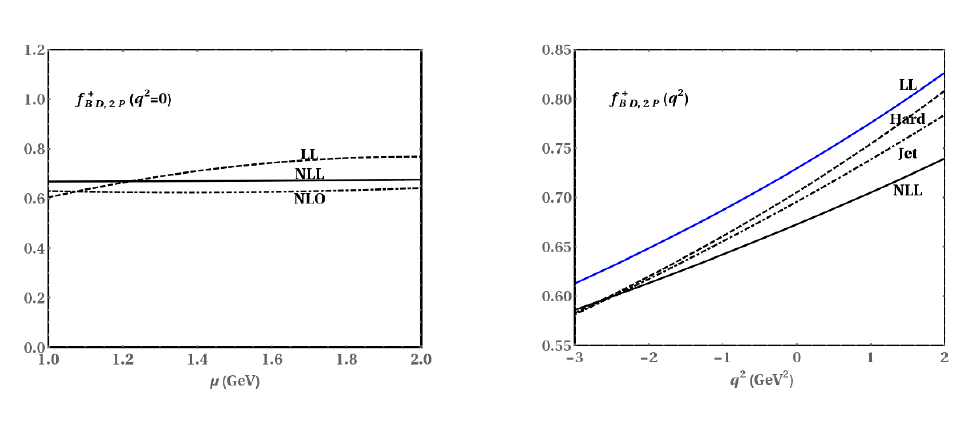
Figure 5 . Left: factorization scale dependence of the two-particle contributions to the form factor f + (0) computed from the sum rules (3.50). The curves labelled with \LL", \NLO" and \NLL" BD are obtained from the resulting predictions at leading-logarithmic (LL), NLO and (partial) NLL accuracy. Right: breakdown of the two-particle contributions to f + the NLL hard correction (\Hard") and from the NLO hard-collinear correction